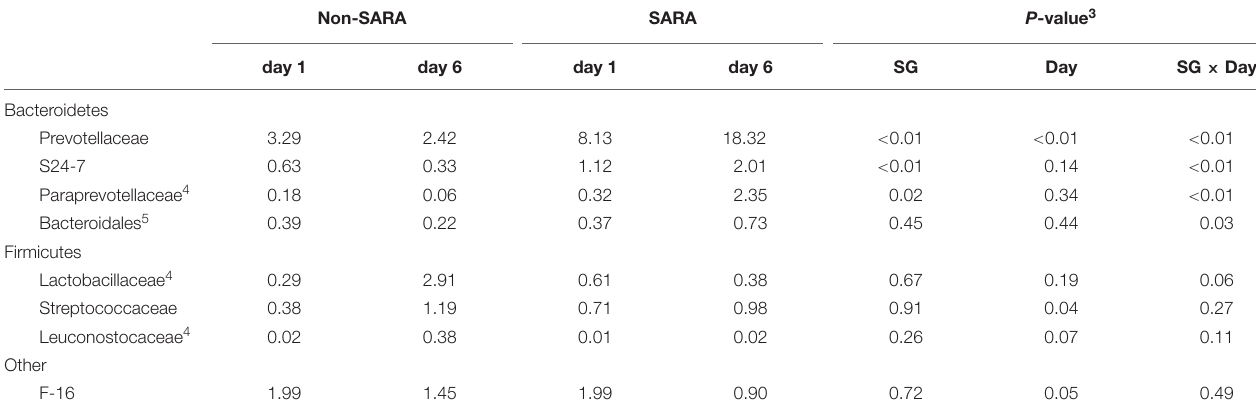
TABLE 4 | Effect of SARA induction on relative abundances of bacterial families in the solid fraction using 16S rRNA sequencing. 1 ,